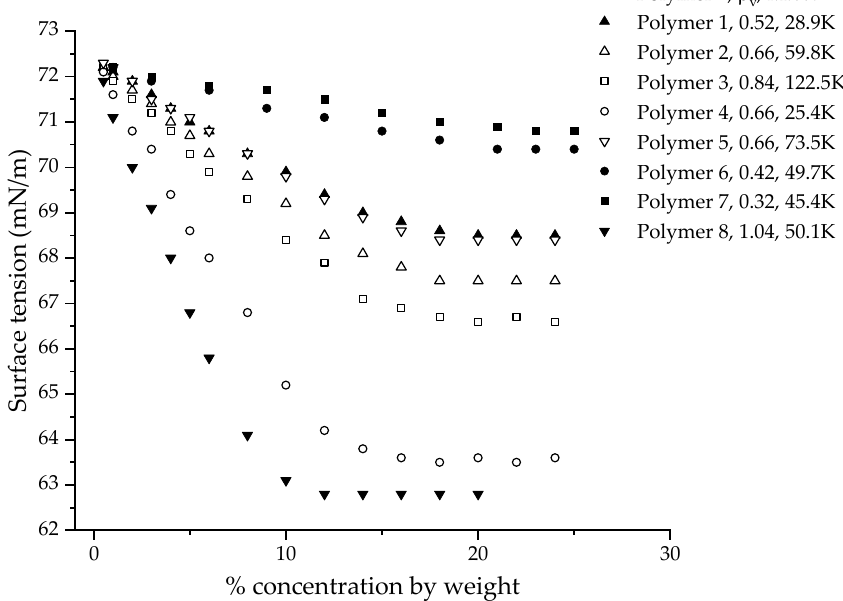
Figure 3. Equilibrium surface tension (mN/m) vs the percentage (%) weight of CUP solution made from polymers 1–8.